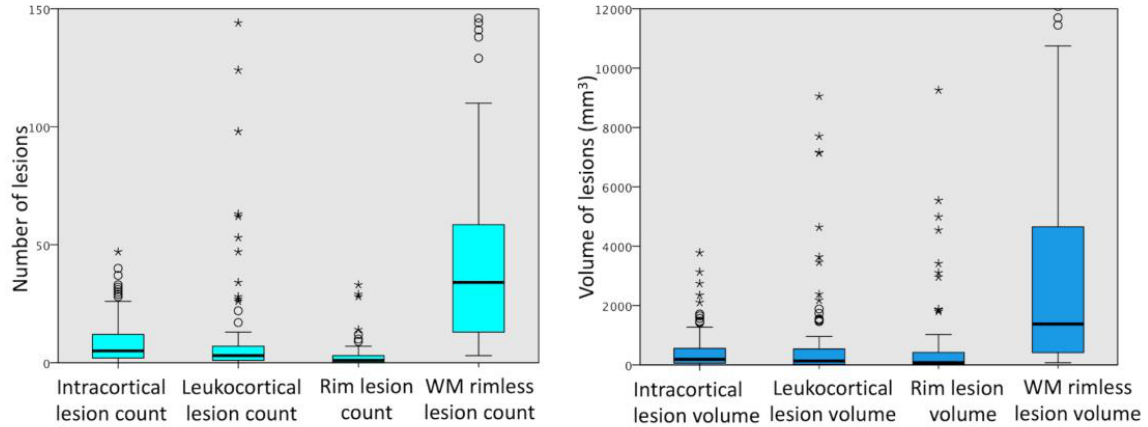
Figure 3. Boxplots summarizing the distribution of the number and volume of different types of cortical and white matter lesions from 100 multiple sclerosis patients. Boxplots represent the median, interquartile range and range. Points outside the whiskers are considered outliers (circles—cases with values between 1.5 and 3 box lengths from the nearer edge of the box; stars—cases lying more than 3 box lengths).